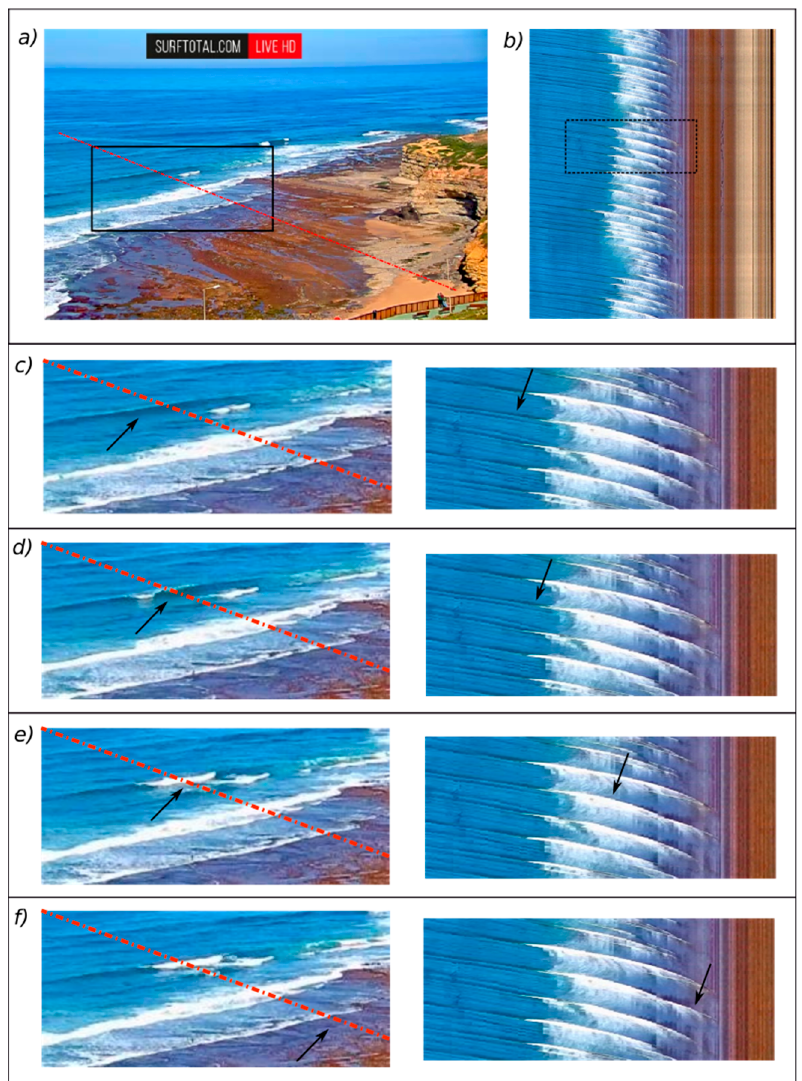
Figure 1. Waves characteristics on Timestacks. Sample taken from Ribeira d’Ilhas dataset. ( a ) Original image and transect (dashed red line) to generate the ( b ) 10-min Timestack. Black boxes indicate the image area reproduced in detail below. ( c ) Shoaling non-breaking waves troughs are represented as darker straight features on oblique (left) and Timestack image (right); ( d ) breakpoints coincide with the change in pixel intensity, from dark pixel (shoaling) to white pixel (breaking foam); ( e ) broken waves are represented by white pixel stripes on Timestakcs, whereas light white pixels represent ocean foam; ( f ) wave swash movements are identified by the rhythmic cusplikes in the swash